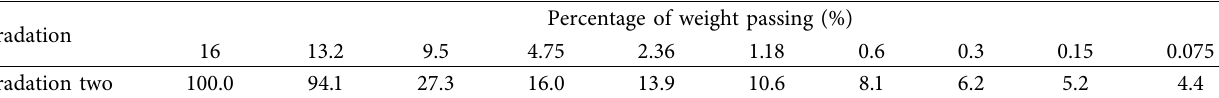
Table 6: Combined aggregate gradation of